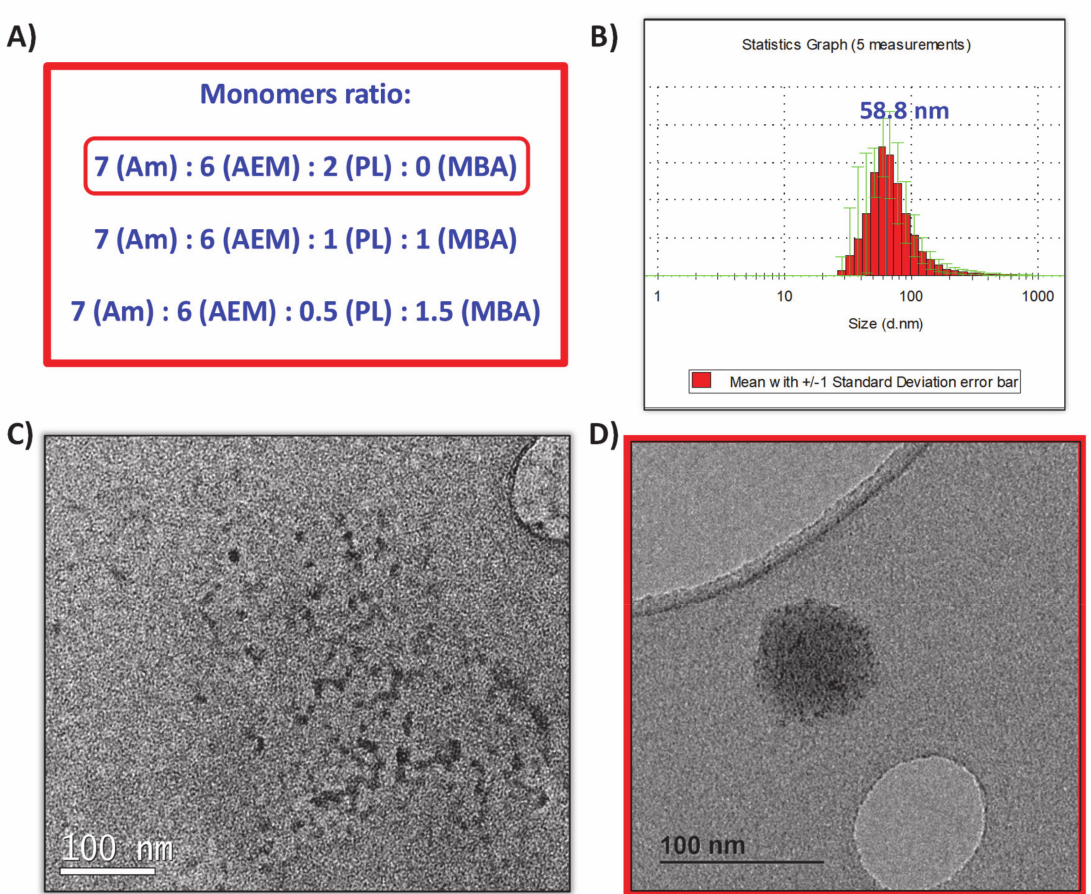
Figure 3. ( A ) Monomers ratio tested for the nanocapsules synthesis. ( B ) DLS obtained for nanocapsules synthetized with the 7:6:2 ratio. ( C ) TEM micrography of free collagenase before encapsulation. ( D ) TEM micrography of obtained